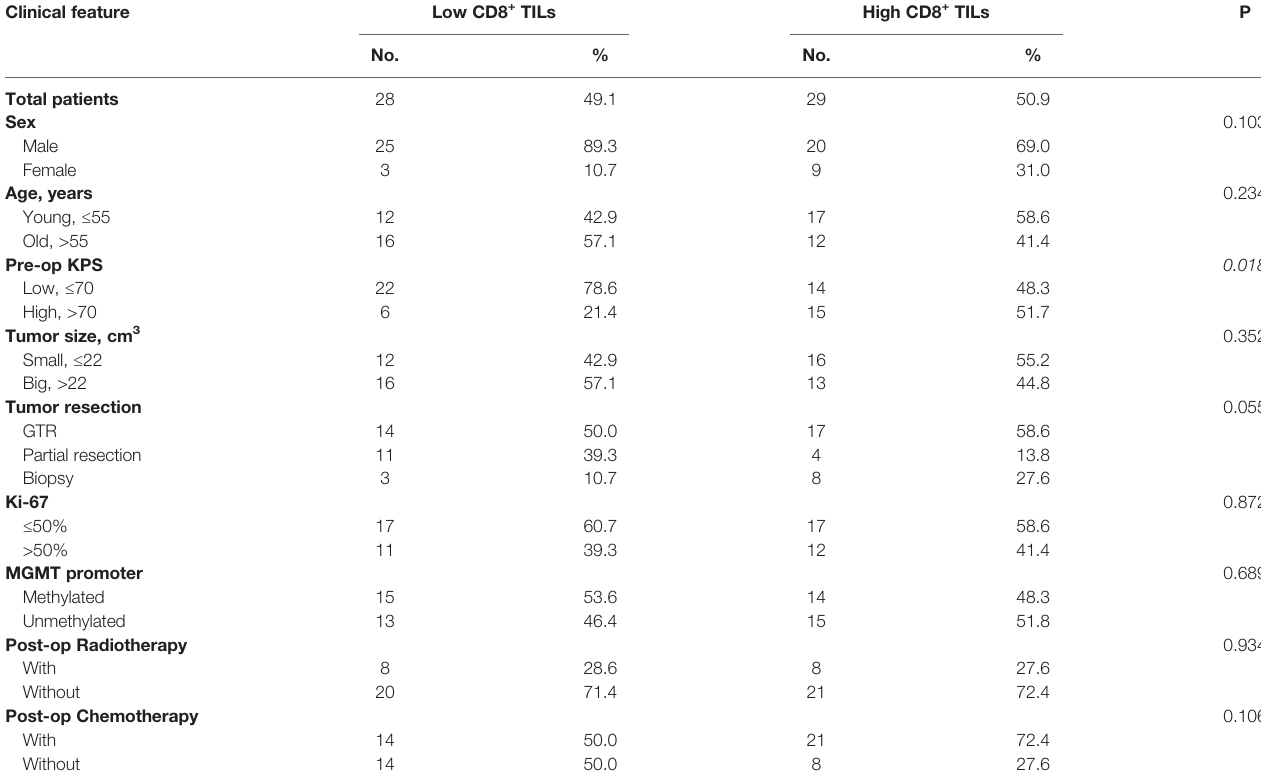
TABLE 3 | Correlation of CD8 + TIL levels and clinical features. Clinical